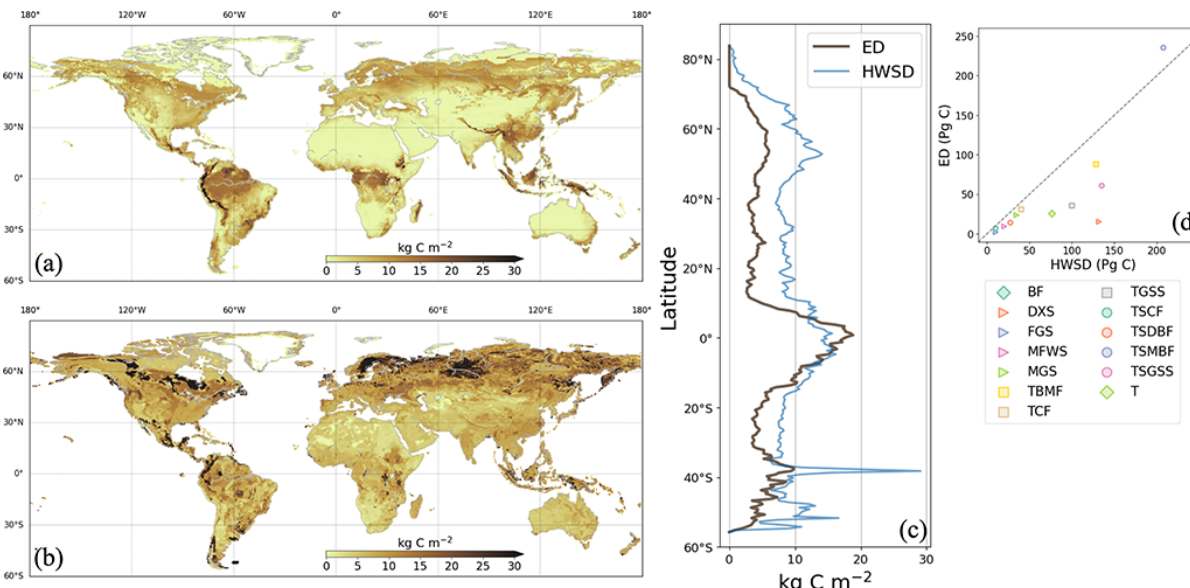
Figure 5. Soil carbon density in 2000 from ED (a) and HWSD (b) . Latitudinal average density and total stocks per biome are compared in (c) and (d) , respectively. In the legend of (d) , BF is boreal forests/taiga, DXS is deserts and xeric shrublands, FGS is flooded grasslands and savannas, MFWS is Mediterranean forests, woodlands, and scrub, MGS is montane grasslands and shrublands, TBMF is temperate broadleaf and mixed forests, TCF is temperate coniferous forests, TGSS is temperate grasslands, savannas, and shrublands, TSCF is tropical and subtropical coniferous forests, TSDBF is tropical and subtropical dry broadleaf forests, TSMBF is tropical and subtropical moist broadleaf forests, TSGSS is tropical and subtropical grasslands, savannas, and shrublands, and T is